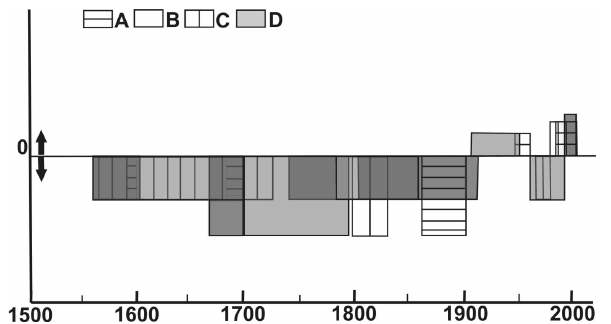
Figure 13. Main climatic events enhanced by anomalies of MAAT through different proxies in all of Europe: A (modified from Luter- bacher et al., 2004); central Europe: B (re-elaborated from Dobro- volný et al., 2010); Alps: C (modified from the same data of Fig. 5; Christiansen and Ljungqvist, 2011) and SSB: D (this